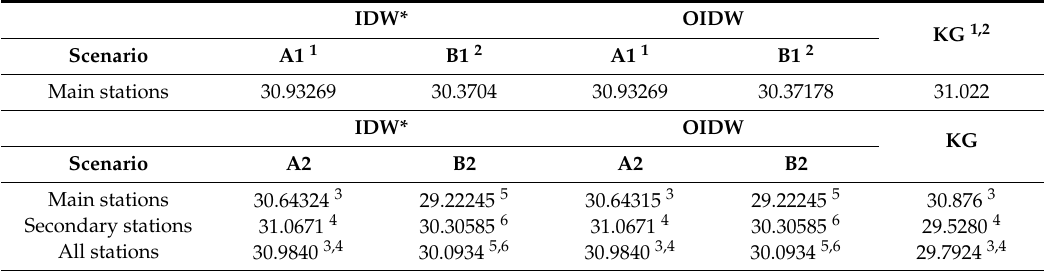
Table 7. Mean values of standard error (average mean squared error (MSE)) over all the series in di ff erent